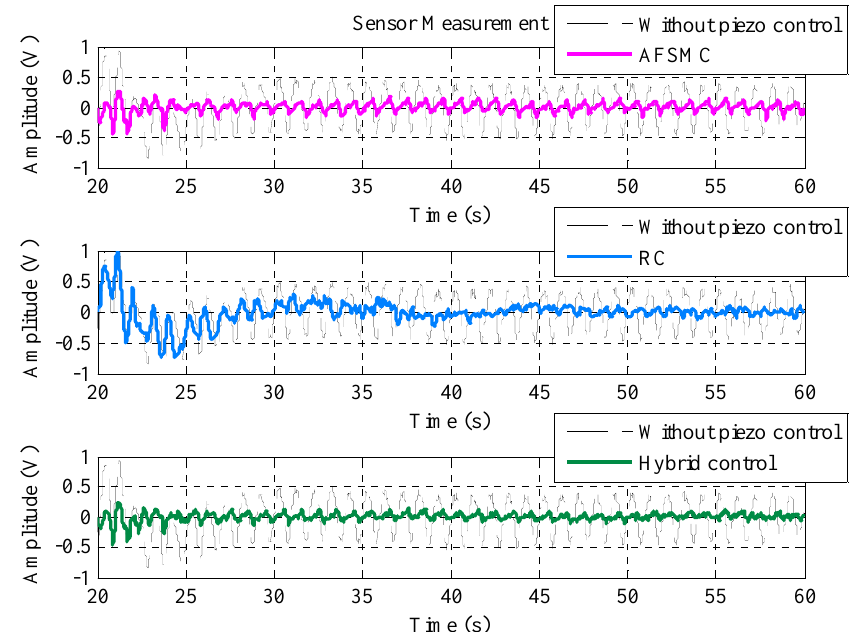
Figure 12. Piezoelectric vibration control in flexible structure: Controlled output responses obtained using: ( top ) AFSMC; ( middle ) RC; and ( bottom ) hybrid AFSMC/RC method.